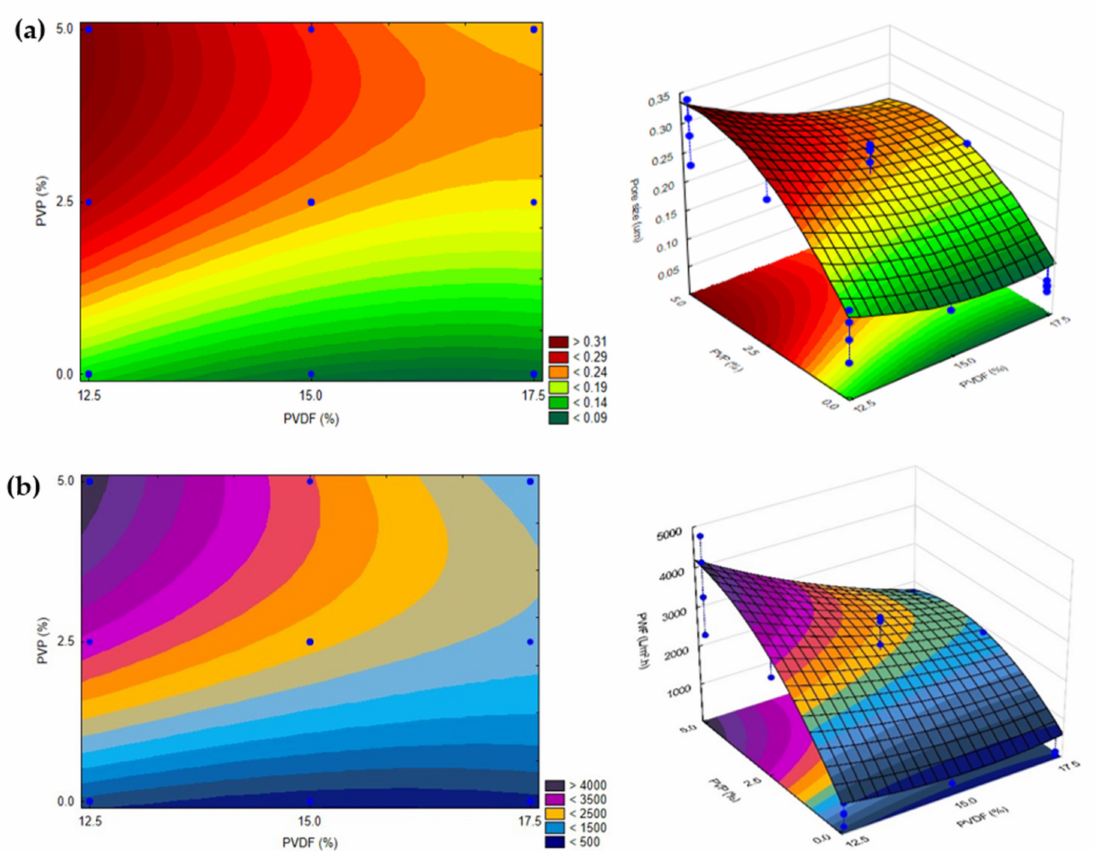
Figure 1. 2 and 3-dimensional surfaces showing the dependence of ( a ) pore size and ( b ) pure water flux on the concentrations of PVP and PVDF at a fixed bath temperature of 20 ◦ C and 30 s of evaporation time. Blue dots represent experimental values within the investigated design space ( n =